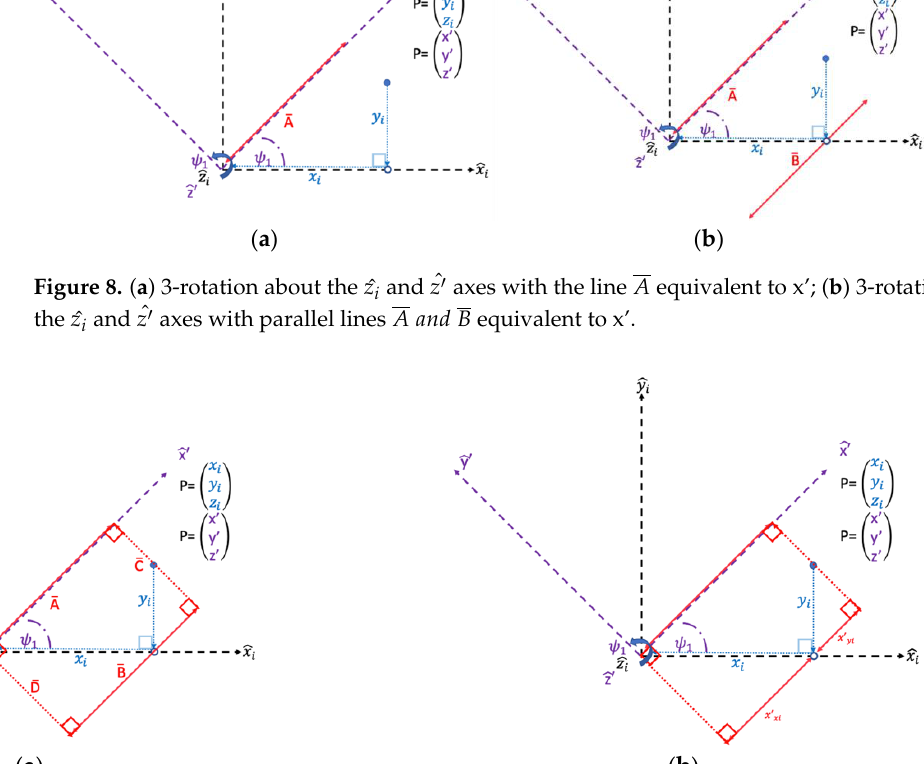
Figure 9. ( a ) 3-rotation about the 𝑧 𝑖 ̂ and 𝑧′̂ axes adding parallel lines 𝐶̅ 𝑎𝑛𝑑 𝐷̅ to create rectangle 𝑧′̂ axes and dividing 𝐵̅ into measurable sections 𝑥′ 𝐴𝐵𝐶𝐷̅̅̅̅̅̅̅̅ . ( b ) 3 - rotation about the 𝑧 𝑖 ̂ and